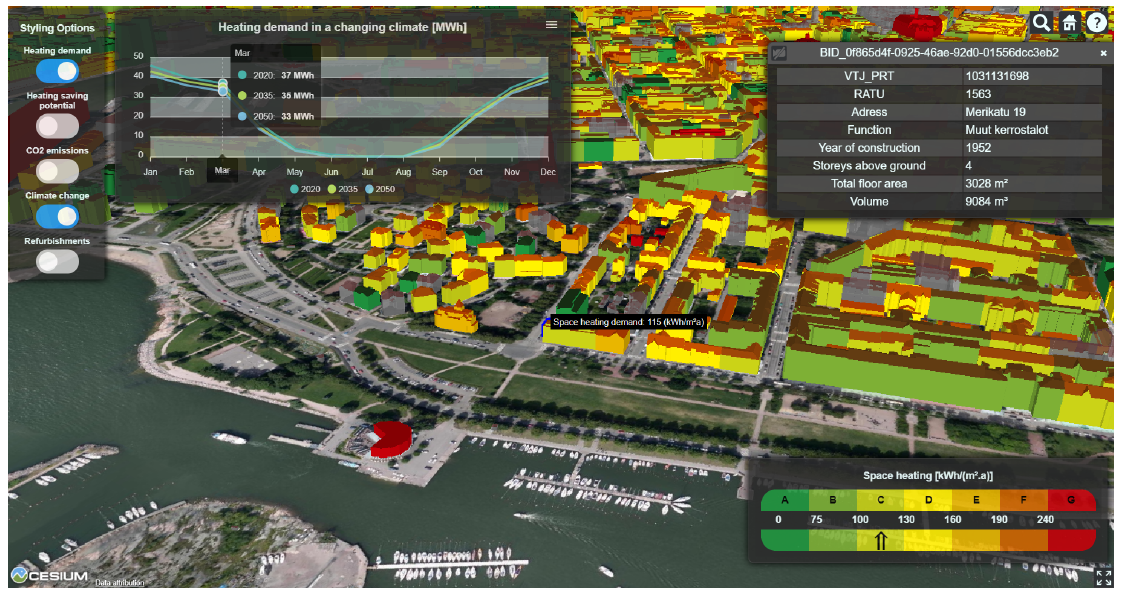
Figure 7. Screenshot of the 3D web visualization, showing the buildings colorized by simulated space heating demand.